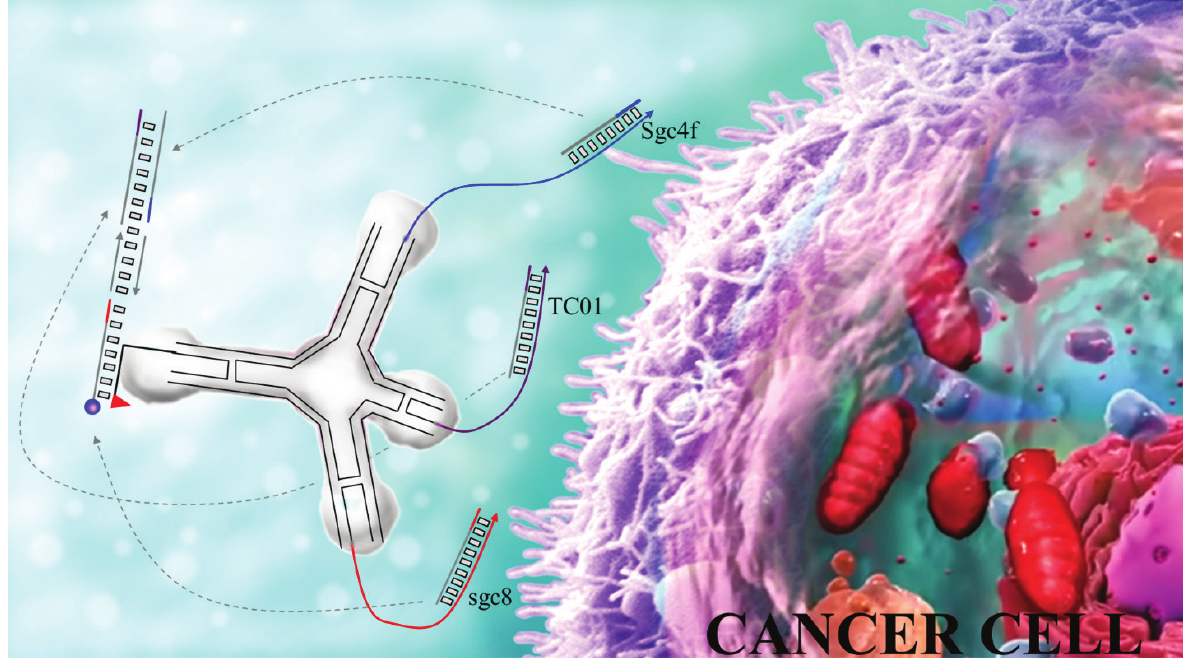
Figure 2. Schematic illustration of the programmed operation of multiparameter theranostics DNA-based nanomachine for log- ic-based autonomous targeting and therapy of cancer